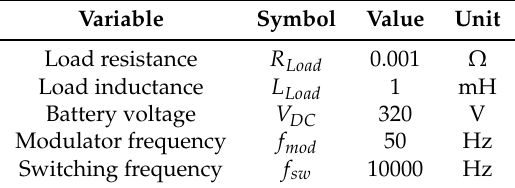
Table 6. The most significant parameters of the open-loop simulation platform.